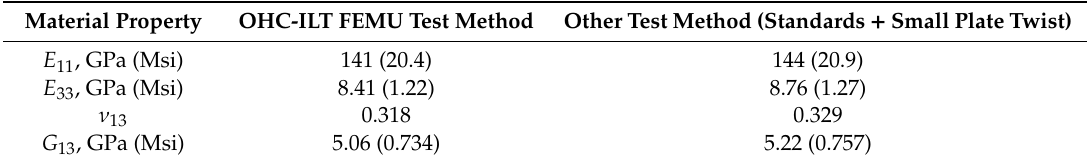
Table 3. Comparison of average constitutive properties obtained using the OHC-ILT test with other test methods for the unidirectional tape material.